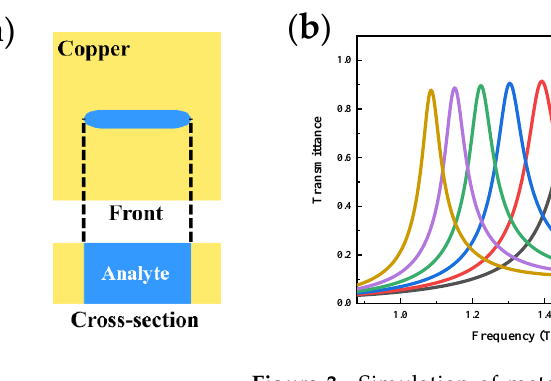
Figure 4. ( a ) Schematic diagram of low-frequency MSA metamaterial; ( b ) Simulated transmittance curves of different RI for the LF-MSA; ( c ) Comparison of the frequency shifts of the two resonance peaks.